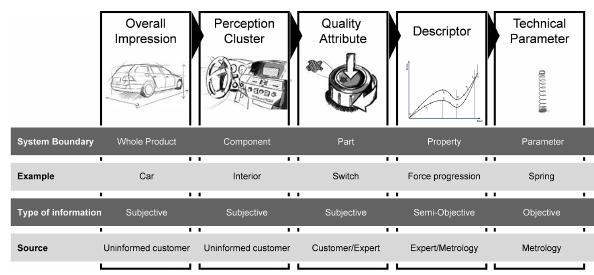
Figure 1. Structured approach towards quality perception referring to Falk et al.